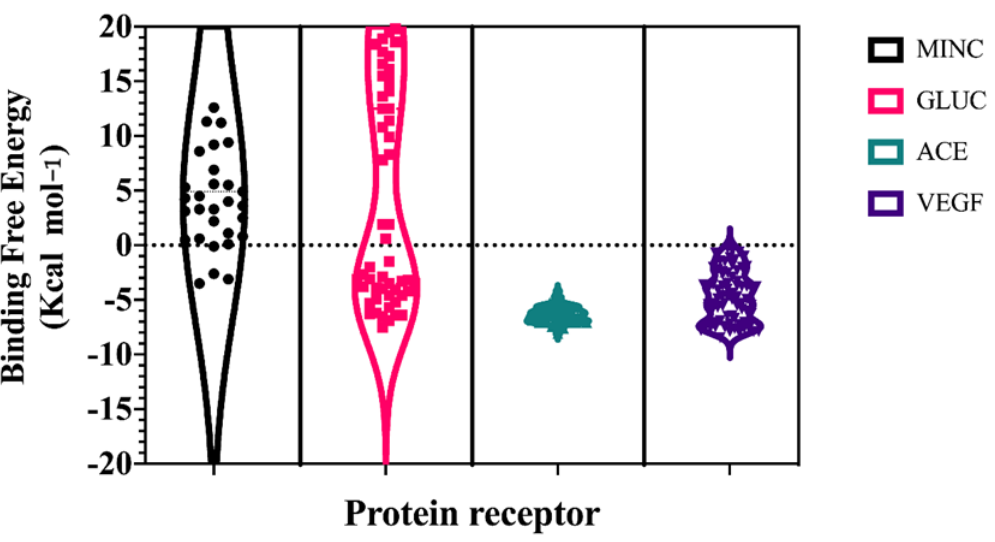
Figure 2. Ensemble docking-virtual screening scores of chia seed peptides towards select human protein targets: MINC (mineralocorticoid), GLUC (glucocorticoid), ACE (angiotensin converting enzyme), and VEGF (vascular endothelial growth factor).